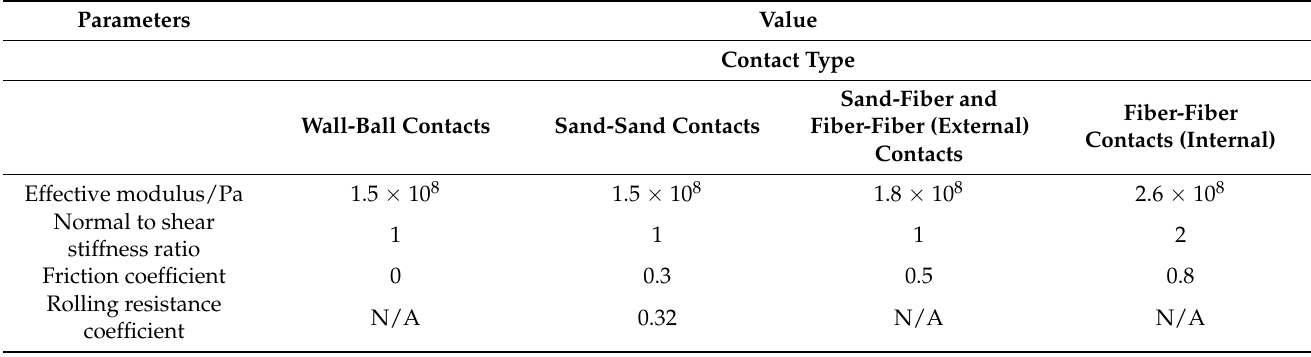
Figure 5. Calibration of microscopic parameters: ( a ) comparison of the direct shear testing result between laboratory and simulation for pure sand; ( b ) comparison of the direct shear testing result between laboratory and simulation for fiber-reinforced sand. Table 2. Microscopic non-bonding parameters calibrated in this study.